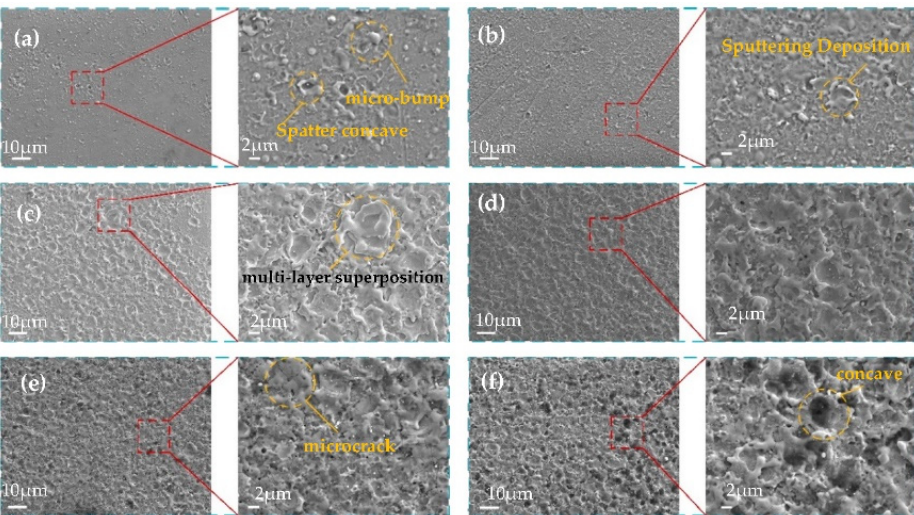
Figure 4. Morphologies of different low-voltage electric current currents: ( a ) 0.5 A; ( b ) 1 A; ( c ) 1.5 A; ( d ) 2 A; ( e ) 2.5 A; ( f ) 3 A.